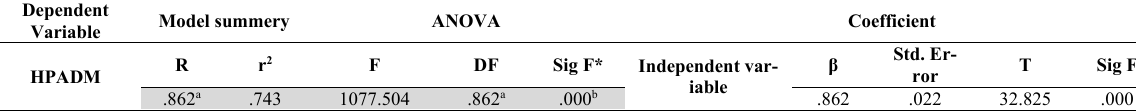
Multiple Linear Regressions Analysis for testing the impact of (PEU, PU, PE,PT) on HPADM Dependent Variable